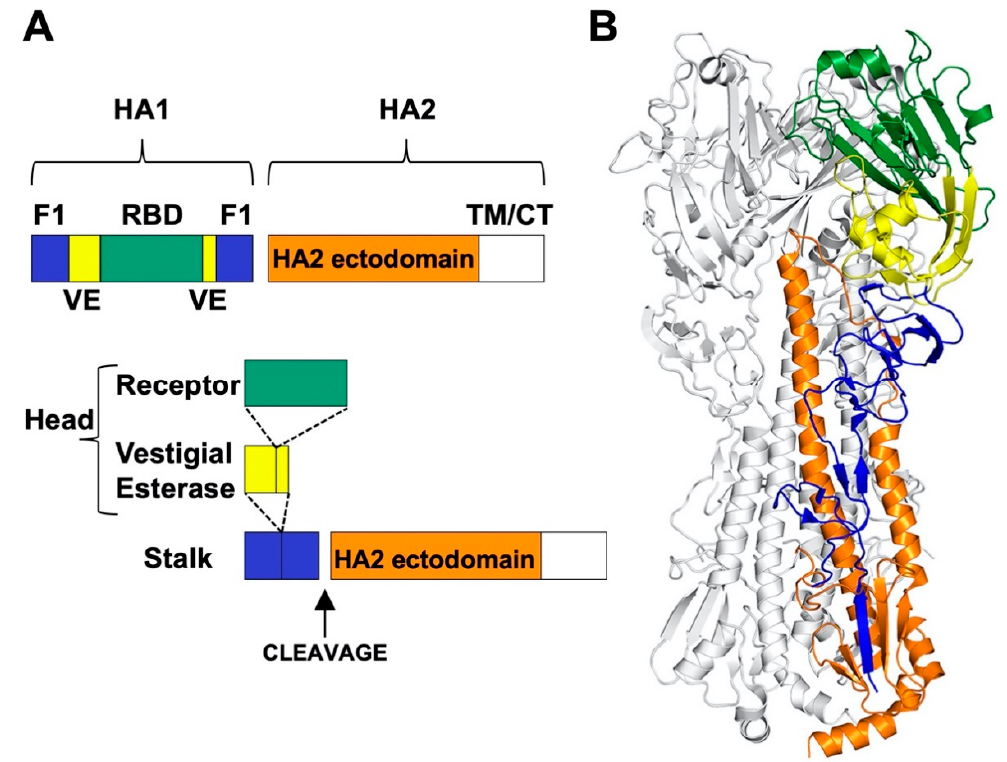
Figure 1. Domain arrangement and prefusion structure of the IAV HA protein. ( A ) Domain structure of the IAV HA protein. Domains in HA1 include fusion (F1, blue), vestigial esterase (VE, yellow), and receptor-binding domain (RBD, green). Domains in HA2 include the HA2 ectodomain (orange), transmembrane region (TM, white), and cytoplasmic tail (CT, white). The HA head includes the receptor-binding (green) and vestigial esterase (yellow) subdomains. The stalk (a.k.a. stem) contains the HA1 fusion domains (blue) and the HA2 ectodomain (orange). The domain insertion schematic was adapted from the influenza C HEF structure [81]. ( B ) Structure of an HA trimer in its prefusion conformation. One protomer is colored based on the conventions established in panel A, and the other protomers are colored gray. Structures were generated using MacPYMOL using A/California/4/2009 (H1N1) protein data bank structure 3UBE [82].